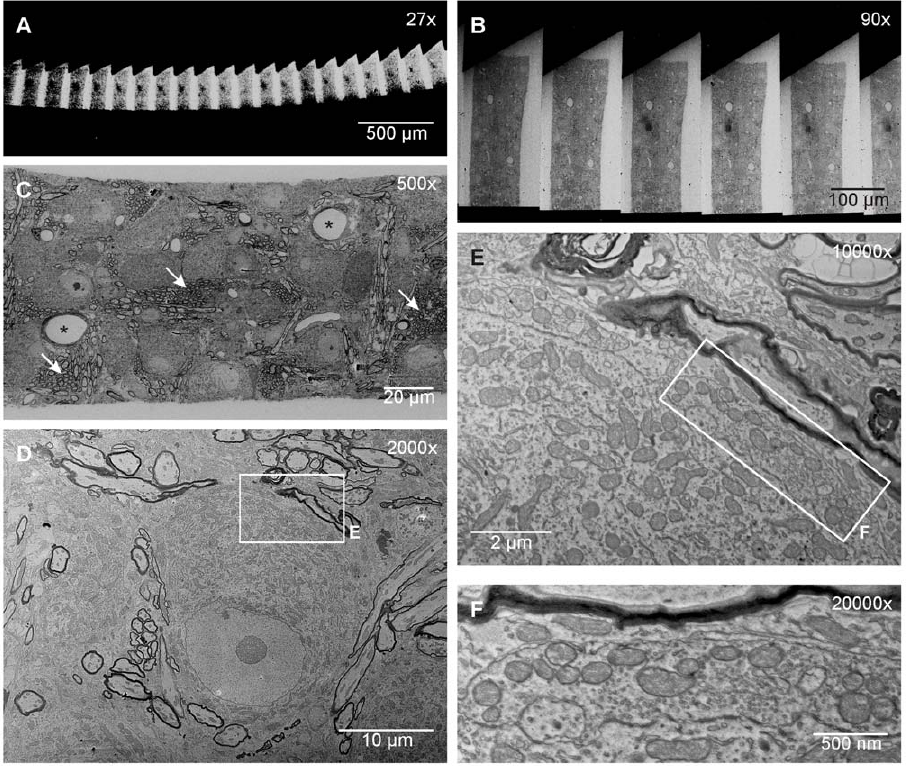
Figure 2. High resolution images can be obtained from ribbons of serial sections via SEM. A: Low magnification SEM image of a ribbon mounted on a silicon wafer. B: Low magnification images of sections cut in trapezoid shape to determine the orientation of the tissue. The sections are evenly space by resin throughout the ribbon. C: Intermediate magnification SEM images that allow the identification of landmarks in the tissue like blood vessels (asterisks) and axon bundles (arrows). D: Intermediate magnification overview image of a MNTB principle neuron. Boxed area is shown at high magnification in E . E, F: High magnification (10,000fold in E , 20,000fold in F ) SEM images of a calyx of Held synapse segment. Boxed area in E is shown at higher magnification in F .